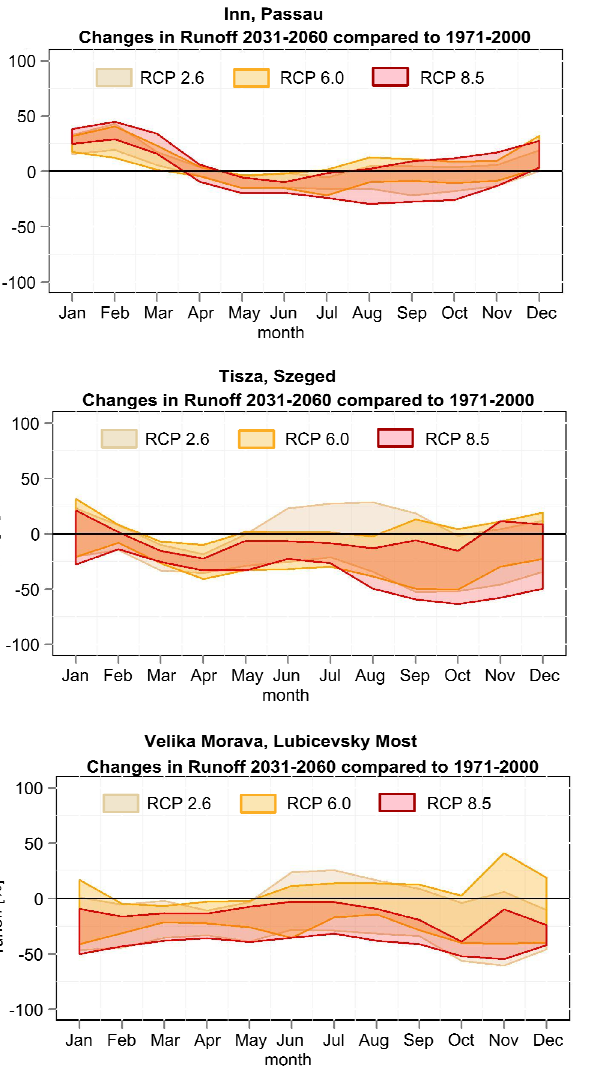
Figure 14. Changes (%) in the mean runoff seasonality between the reference period 1971–2000 and the near future scenario period 2031–2060 for selected stations in the Danube River catchment driven by ISI-MIP scenarios showing the range of five GCMs for each RCP (RCP2.6, RCP6.0 and RCP8.5). The ISI-MIP scenarios refer to a global warming level compared to that preindustrially (1850–1900) until 2071–2100 of 2 °C (RCP2.6), 3 °C (RCP6.0) and 4 °C